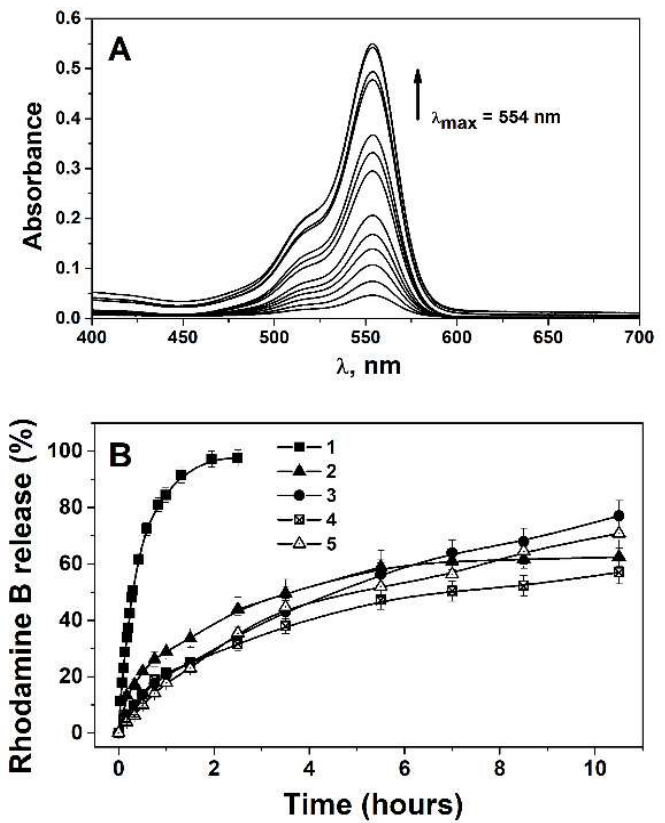
. Figure 3. Spectra ( A ) and release profile ( B ) of Rhodamine B in free solutions (without nanoparticles) (1), from PC-liposomes (2) and PC/ 3l -lipososmes (3–5) with ratio 98/2 (3), 95/5 (4), and 90/10 (5), (n = 3, 3 times were replicated), phosphatebuffer (0.025 M), pH = 7.4, 37 ◦